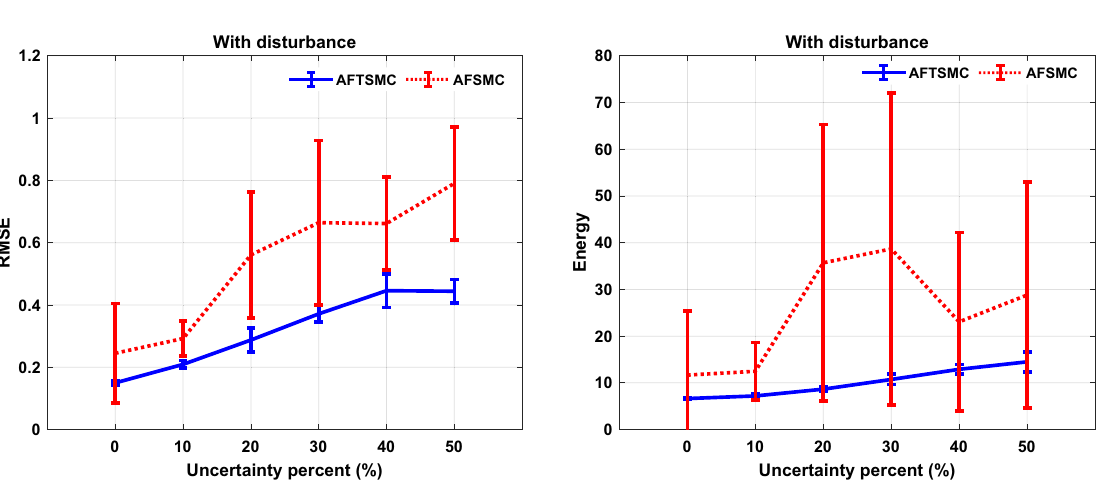
Figure 11. Results of the mean RMSE and Energy over 10 trials of the simulation under time-varying system parameters and external disturbance using AFTSMC in comparison with classical AFSMC. SD bars are depicted for 10 trials of simulations in each